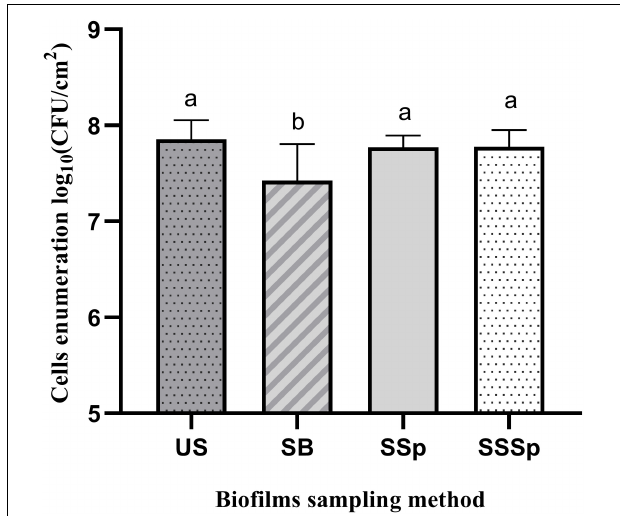
FIGURE 7 | Recovery of P. azotoformans Pfl1A cells from biofilm grown on stainless-steel slides in sterile skim milk, by ultrasonicating (US), sonic brushing (SB), synthetic sponge (SSp), sonicating synthetic sponge (SSSp). Values are mean ± SD ( n = 3). Significant differences (different letters, p < 0.05) are based on one-way ANOVA and Dunnett’s multiple comparison